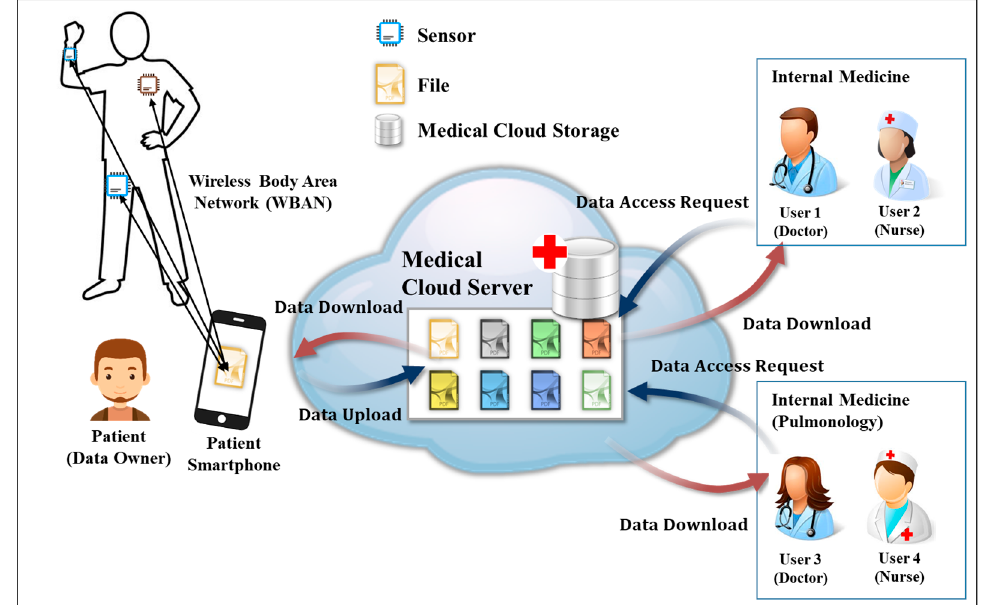
Figure 1. Data sharing system in a medical cloud environment.